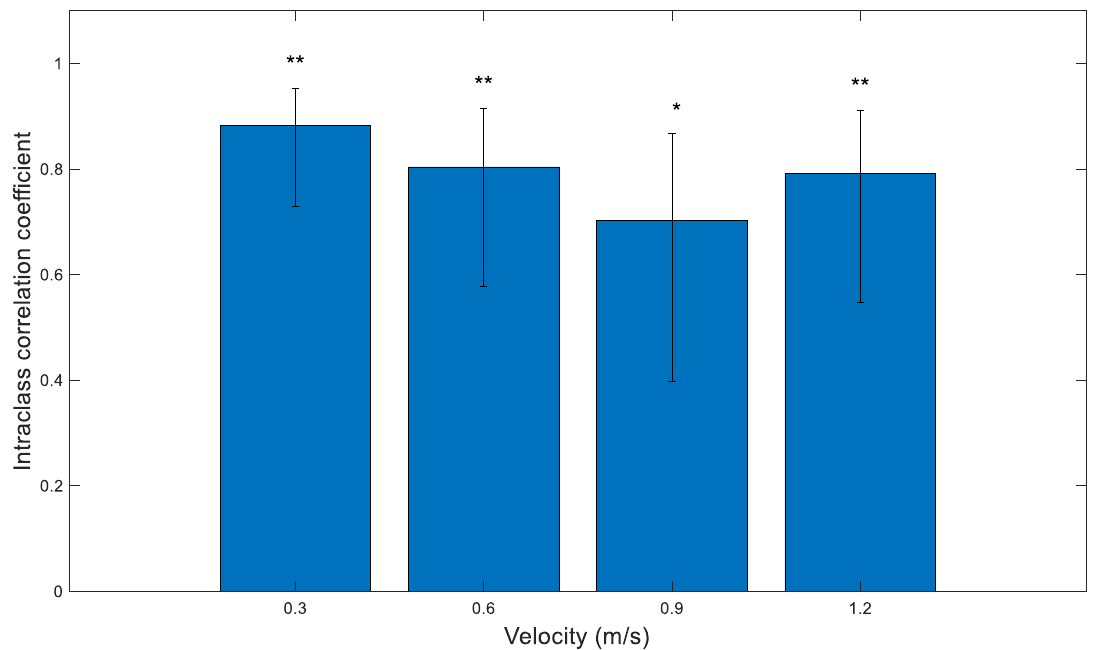
Figure 6. Single measure intraclass correlation coefficients (ICC) between the number of right limb EMG peaks of the medial gastrocnemius detected by mTrigger and DELSYS at different speeds for overground walking with 95% confidence interval. All correlations were significant at p < 0.05. Agreement: * = moderate, ** = good.